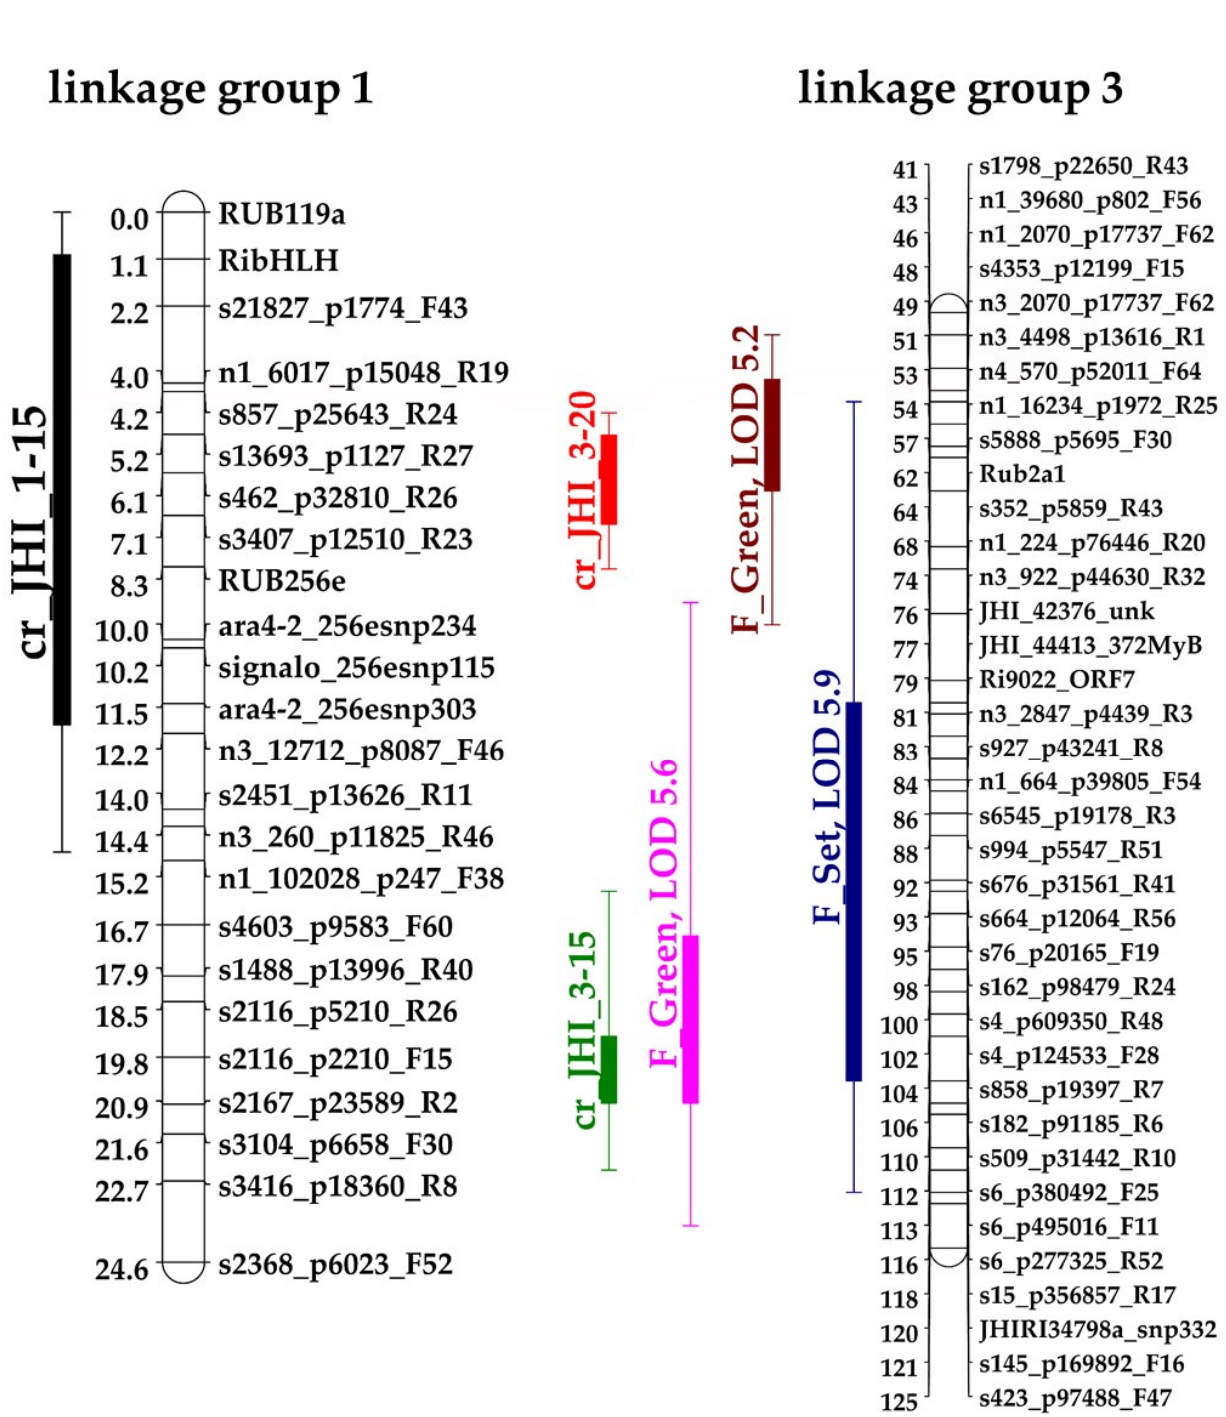
Figure 1. Sections of the Genotype by Sequencing (GbS) linkage maps for linkage groups 1 and 3 of the Glen Moy x Latham mapping population [4]. Bars and whiskers (to the left of the chromosome) show one- and two- logarithm of the odds (LOD) support intervals for Quantitative Trait Loci (QTL) locations. The linkage group 1 shows a crumbly fruit QTL in black (cr_JHI_1–15 with LOD 6.1 and with 1–12 cM and 0–15 cM of one and two LOD supporting intervals). The linkage group 3 shows two crumbly fruit QTLs, one in red (cr_JHI_3–20 with LOD 6.3 and with 52–60 cM and 50–64 of one and two LOD supporting intervals) and one in green (cr_JHI_3–15 with LOD 6.0 and 106–112 cM and 93–118 of one and two LOD supporting intervals) and three fruit ripening QTLs (i.e., fruit set, green fruit), in blue, purple, red, and pink, respectively. The sections of the two linkages groups are drawn using a reduced number of markers to make a clear and neat image. In the Supplementary Materials, Figure S1, the two linkage groups with the complete list of markers are